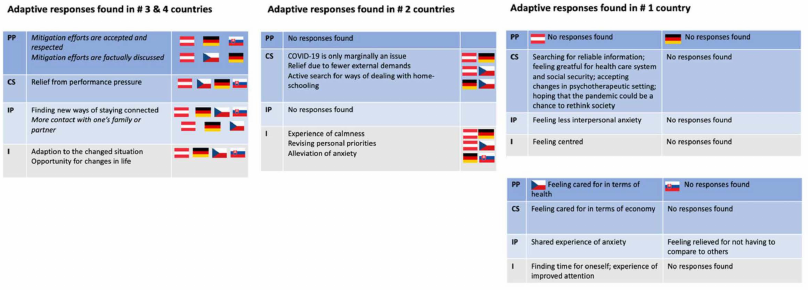
Figure 5. Adaptive responses that could potentially positively contribute to a patient’s health state were found in #4 and #3 countries, #2 countries, and #1